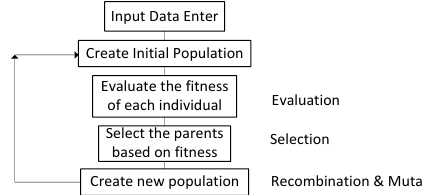
Figure 2. Genetic algorithm optimization